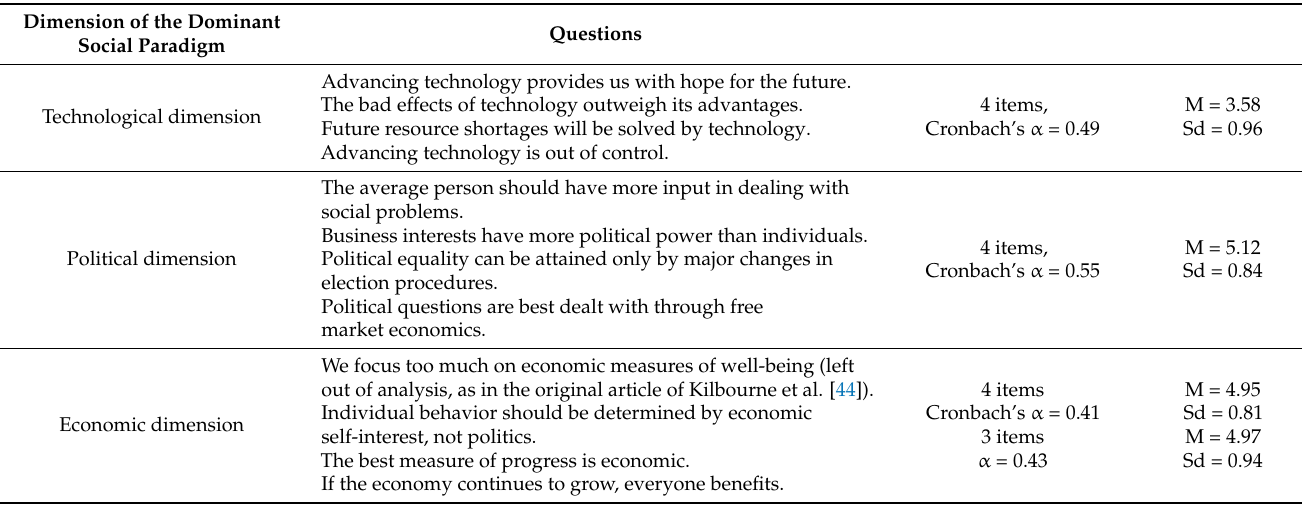
Table A1. Main elements of the dominant social paradigm—survey questions and results.